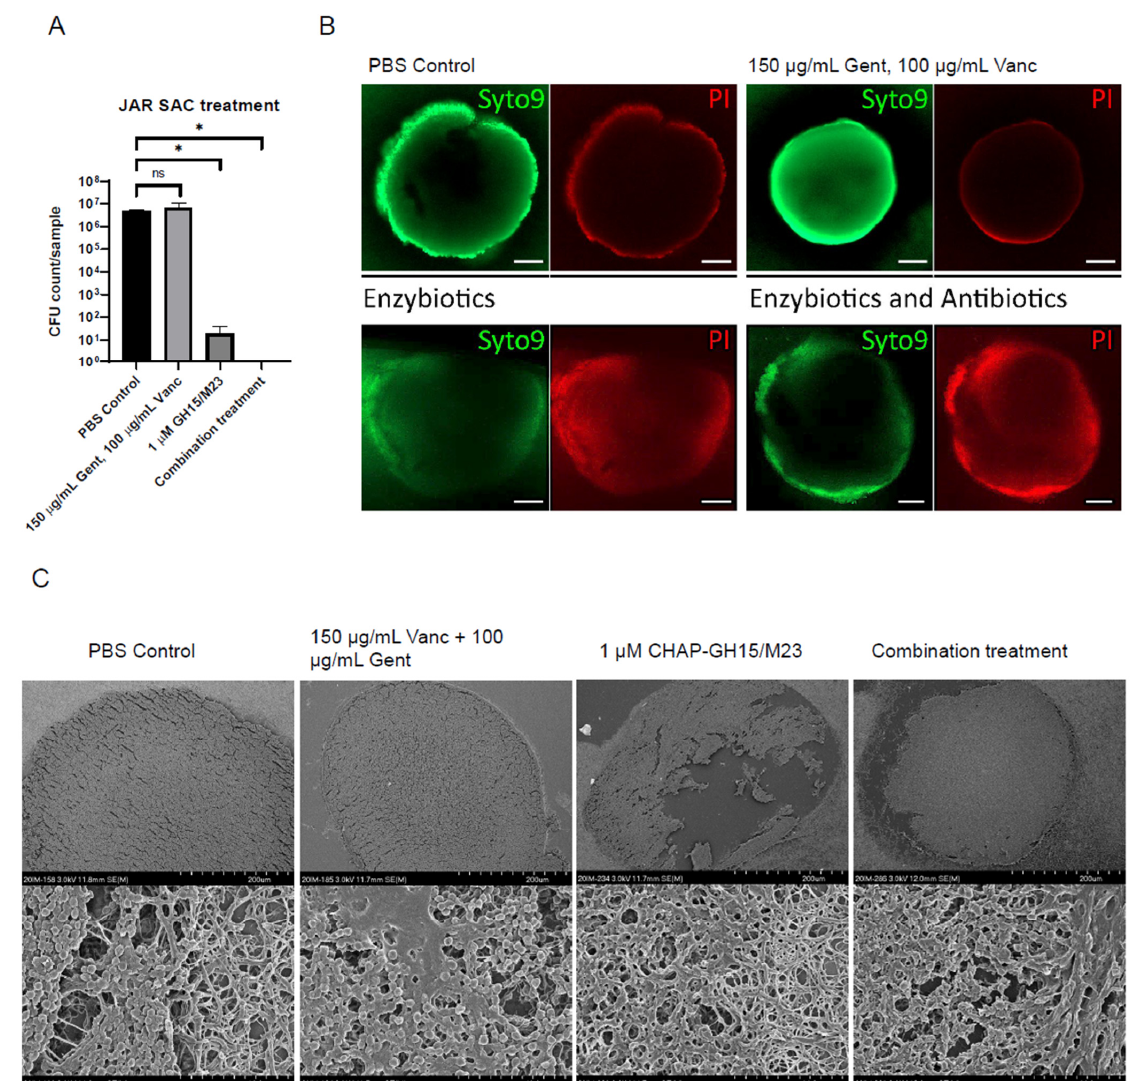
Figure 4. Enzybiotics are effective at treating an in vitro staphylococcal abscess communities (SAC) model. ( A ) Resulting CFU counts per sample of 24-h SACs treated with enzybiotics and antibiotics. Combination treatment indicates a full treatment with 150 µg/mL Gent, 100 µg/mL Vanc, 1 µM equimolar CHAP-GH15/M23 ( n = 3). ( B ) Representative fluorescence microscopy images of treated SACs as in ( A ) stained with nucleic acid dyes Syto9 (green, membrane-permeable) and propidium iodide (red, non-membrane-permeable). Scale bars are 100 µm. ( C ) SEM images of treated SACs as in ( A ). Overview images are in the top panel, and magnified images are in the bottom panel. Scale bars are indicated at the bottom of each image. * p ≤ 0.05, ns = not significant.